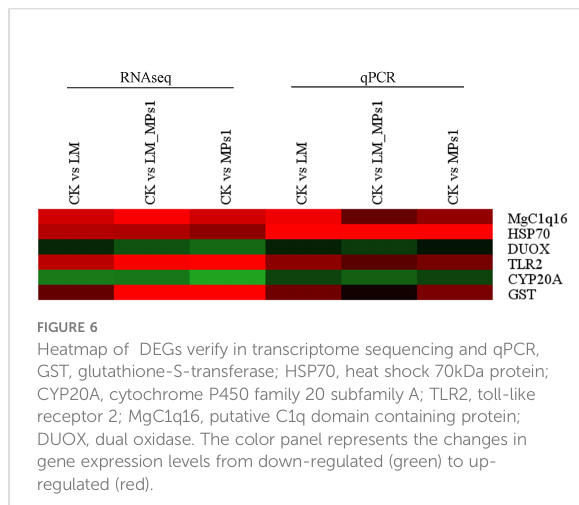
FIGURE 6 Heatmap of DEGs verify in transcriptome sequencing and qPCR, GST, glutathione-S-transferase; HSP70, heat shock 70kDa protein; CYP20A, cytochrome P450 family 20 subfamily A; TLR2, toll-like receptor 2; MgC1q16, putative C1q domain containing protein; DUOX, dual oxidase. The color panel represents the changes in gene expression levels from down-regulated (green) to up- regulated